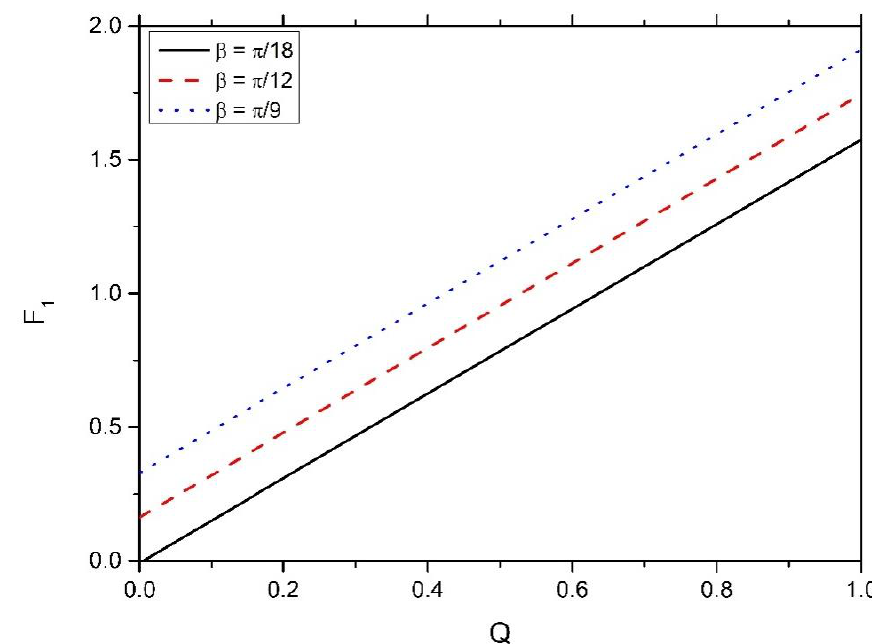
N = 0.3, N = 0.4,  = 0.01,  =0.5, Br = 0.3, b t  = 0.01. 1